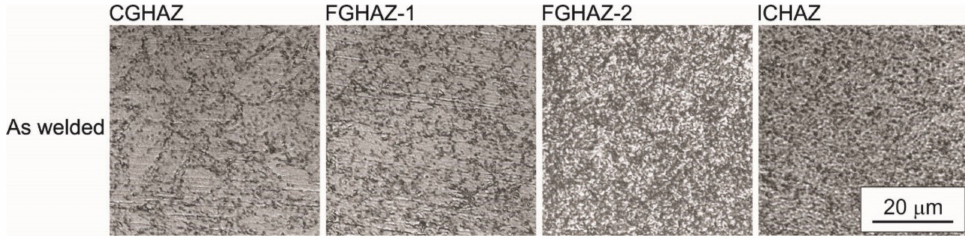
Figure 11. Microstructures of HAZ subzones without